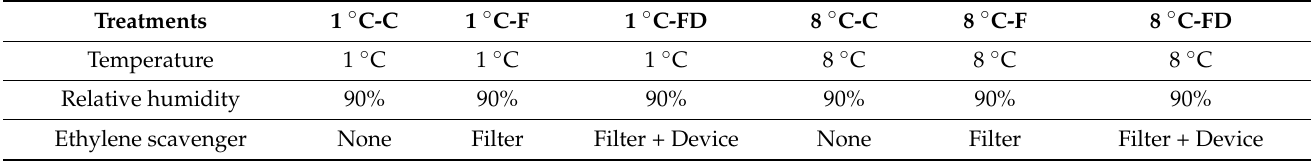
Table 2. Classification of the treatments applied according to storage temperature ( ◦ C), relative humidity (%) and the presence or absence of ethylene